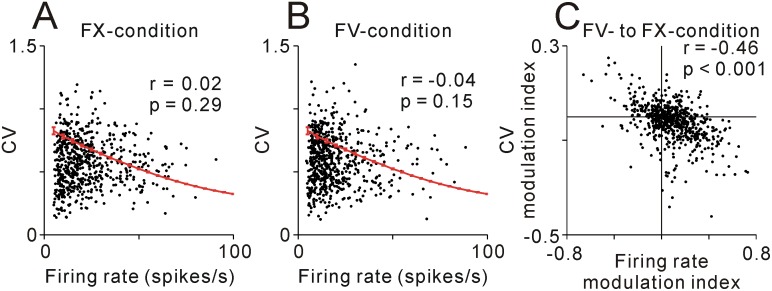
Relationship between firing rate and CV.
(A, B) Plot of mean CV vs. firing rate of neurons recorded during the FX-condition (A, r = 0.02, p = 0.29) or during the FV-condition (B, r = -0.04, p = 0.15). Red lines indicate the mean and 1 SD of CV simulated from the random spike trains over a range of mean firing rates between 5 and 100 spikes/s. (C) Plot of the modulation of mean CV vs. firing rate as the monkeys’ behavior moved from the FV- to FX-conditions (r = -0.46, p < 0.001), indicating a tendency for increased regularity with increased firing rate.